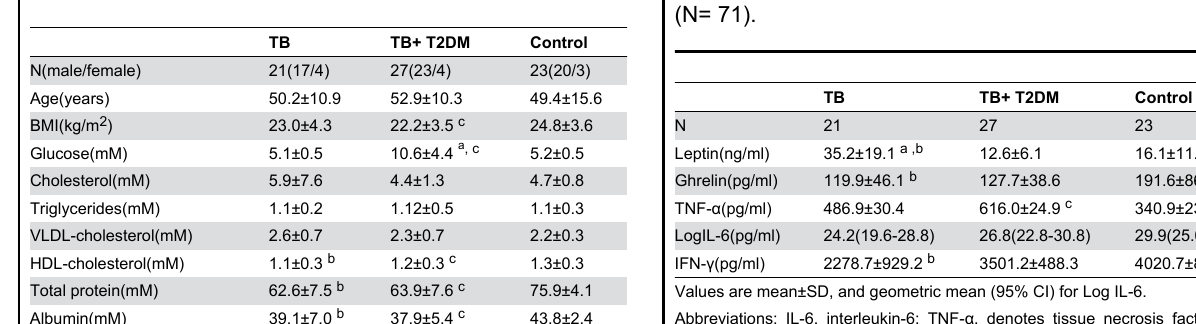
Table 1. Characteristics of the study subjects (N= 71). Table 2. Circulating levels of appetite-related hormones and inflammatory cytokines in patients and healthy subjects